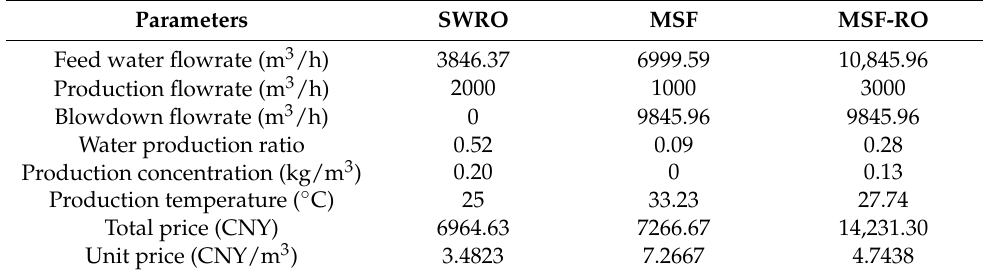
Table 25. Overall water production in option 6.